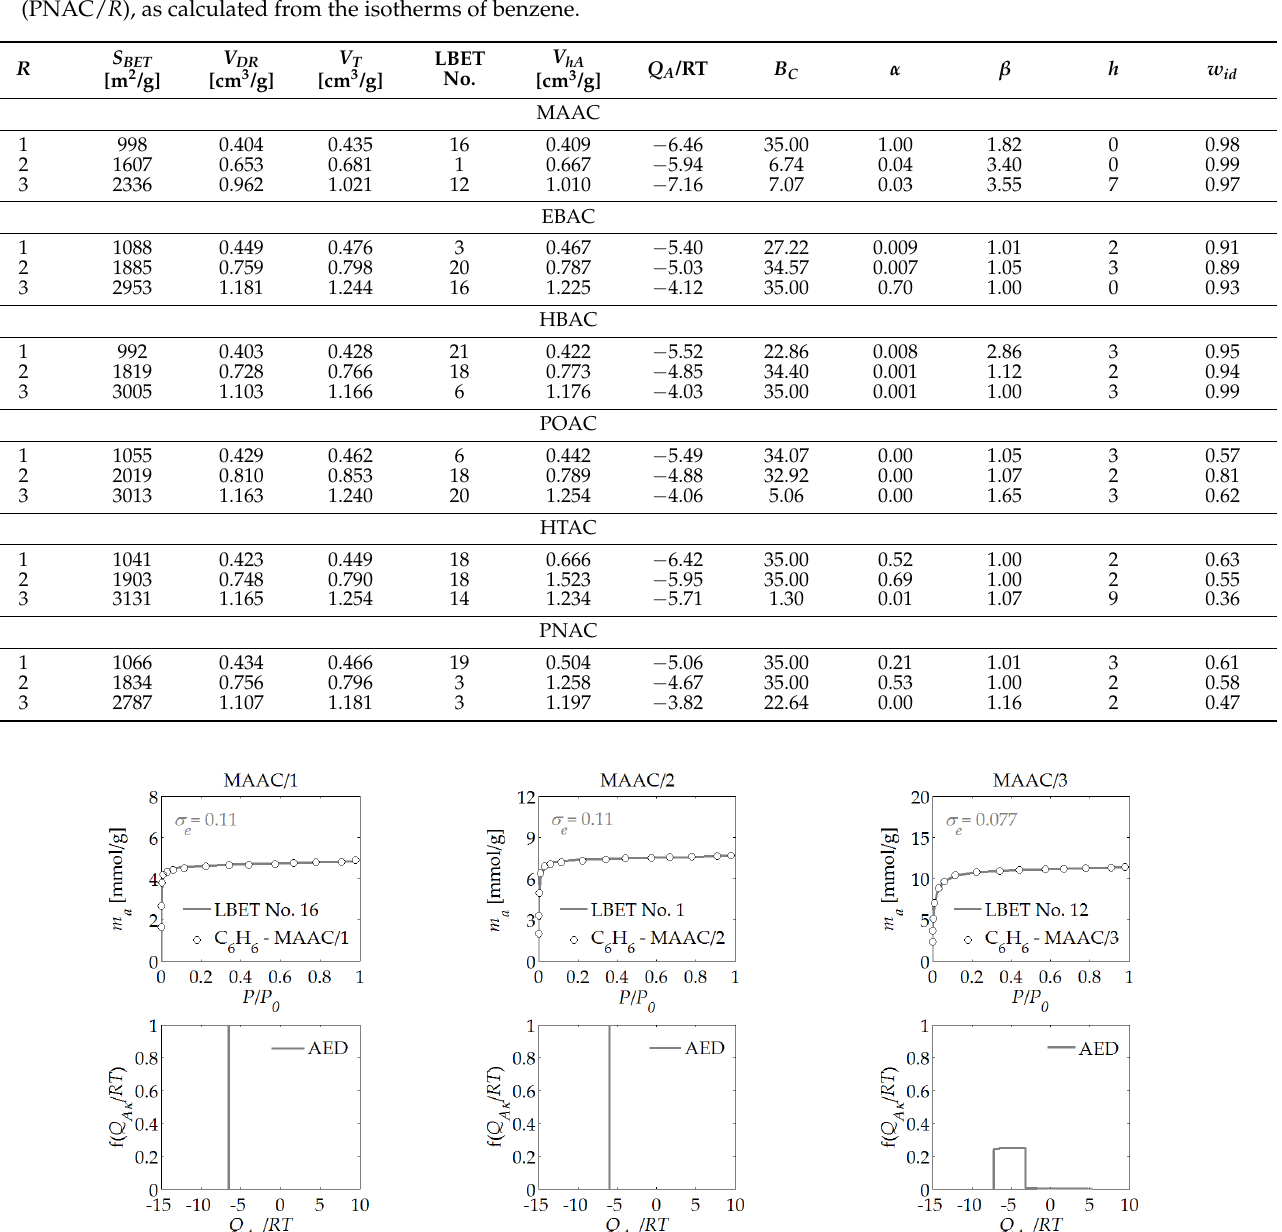
Figure 1. The benzene adsorption isotherms and the results of the identification of the adsorption systems via the LBET method, and adsorption energy distributions (AEDs) obtained for the MAAC/ R active carbons, which were derived from mahogany wood.